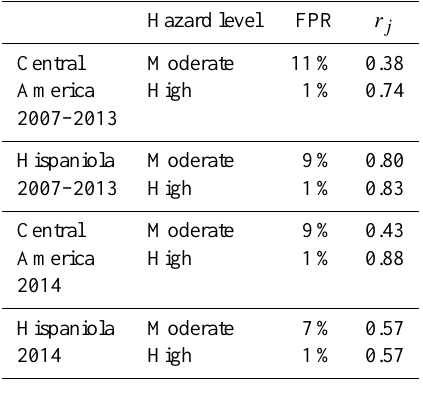
Table 3. False positive rate (FPR) and distance to perfect classifica- tion ( r j ) for both high-hazard and moderate-hazard nowcasts. The moderate-hazard model was calibrated for the period 2007–2013 in Central America, so it is not surprising that this location has the low- est r j value. Because the high-hazard nowcast is a heuristic model intended to identify only the most extreme conditions while mini- mizing false alarms, r j values are expected to be large.